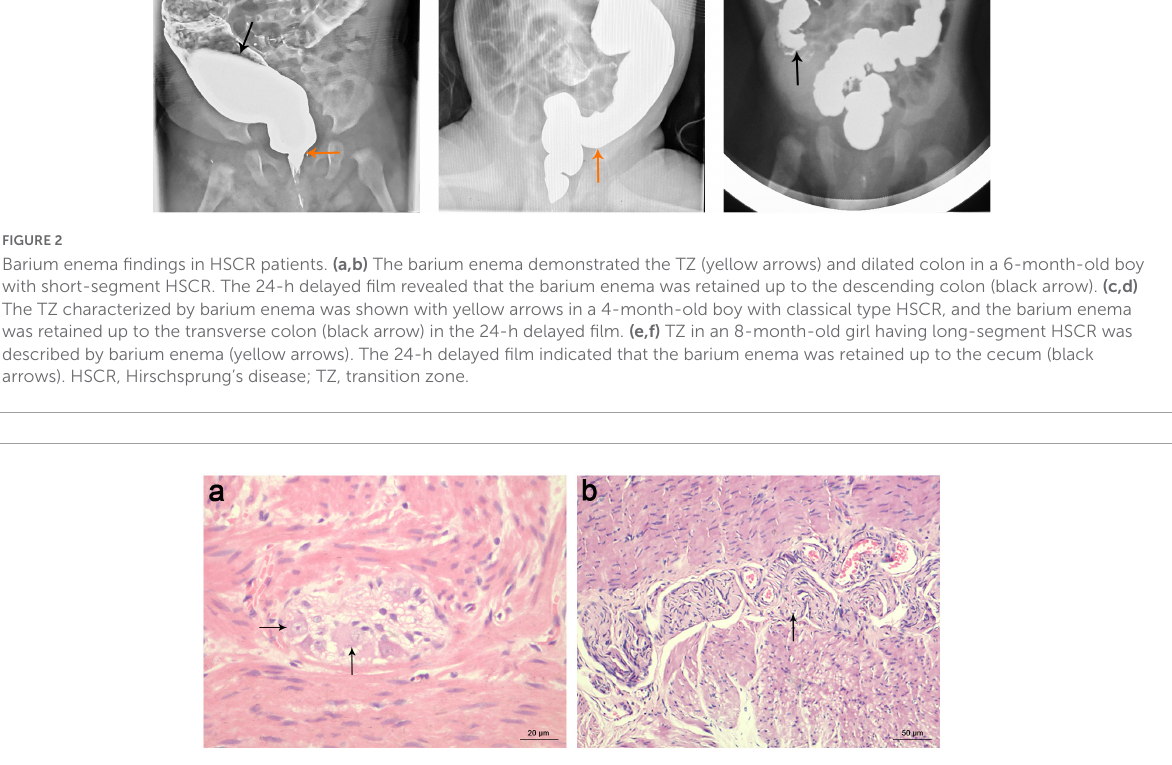
FIGURE3 HE staining of ganglion cells in a 4-month-old boy diagnosed with HSCR. (a) The presence of normal ganglion cells was indicated with black arrows in the colon 10 cm above the proximal barium retention level. scale bar = 20 µ m. (b) The absence of ganglion cells in the distal colon was replaced by hypertrophied nerve trunks, which were indicated with black arrows. scale bar = 50 µ m. HE, hematoxylin-eosin; HSCR, Hirschsprung’s